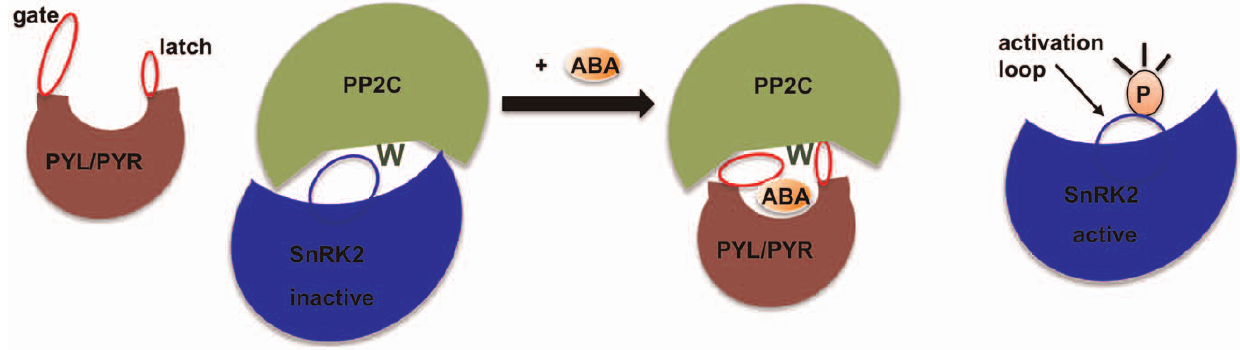
Figure 1. Cartoon presentation of the ABA core signaling pathway. In the absence of ABA, PYR/PYL receptors are in an ‘‘open’’ conformation with the ‘‘gate’’ loop facing away from the ligand-binding pocket and the ‘‘latch’’ loop. PP2Cs are active and bind to and inhibit SnRK2s by dephosphorylation of the activation loop as well as by allosteric inhibition. ABA-binding induces a conformation change in the receptors which causes the ‘‘gate’’ loop to swing in a closed position and a conserved tryptophan residue (represented as dark green W) on the PP2C surface ‘‘locks’’ the ligand in the pocket, forming a catalytically inactive receptor/ligand/phosphatase complex. PP2C inhibition allows SnRK2 activation by activation loop phosphorylation, which enables SnRK2s to transduce the ABA signal by phosphorylating downstream effectors.